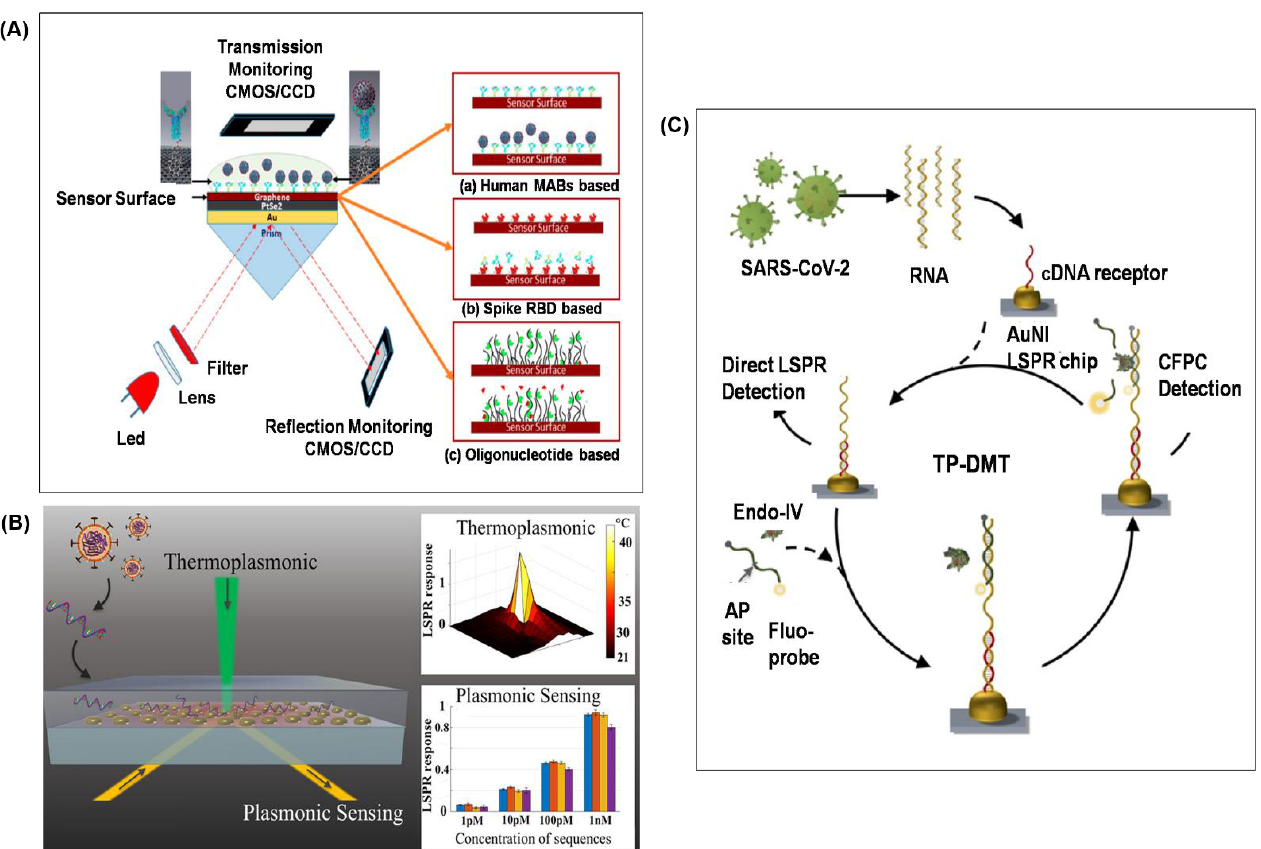
Figure 3. SPR and LSPR biosensor for SARS-CoV-2 detection. ( A ) Graphene-based multiple-layer coated (Bk 7 /Au/PtSe 2 /Graphene) SPR biosensor. Reprinted with permission from [35]. ( B ) Dual-functional PPT enhanced LSPR biosensing system. Reprinted with permission from [37]. Copyright 2020, American Chemical Society. ( C ) Thermoplasmonic-assisted dual-mode transducing (TP-DMT) biosensing system. Reprinted with permission from [38]. Copyright 2021, American Chemical Society.